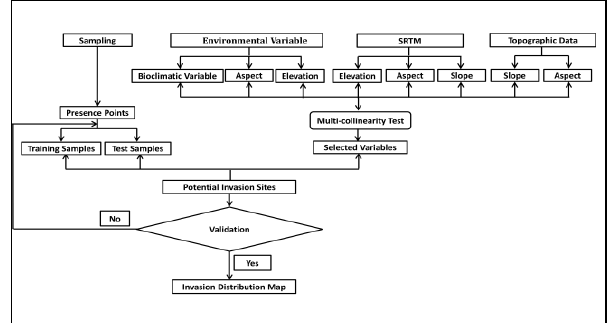
Figure 3. Work flow diagram for Maxent modeling